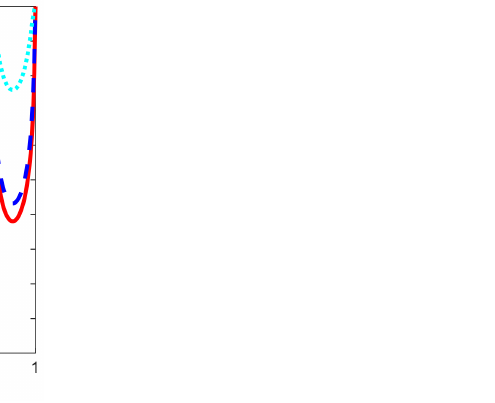
Figure 8. Equivalent Capon power spectrum of constructed covariance matrix in the transmit dimension.